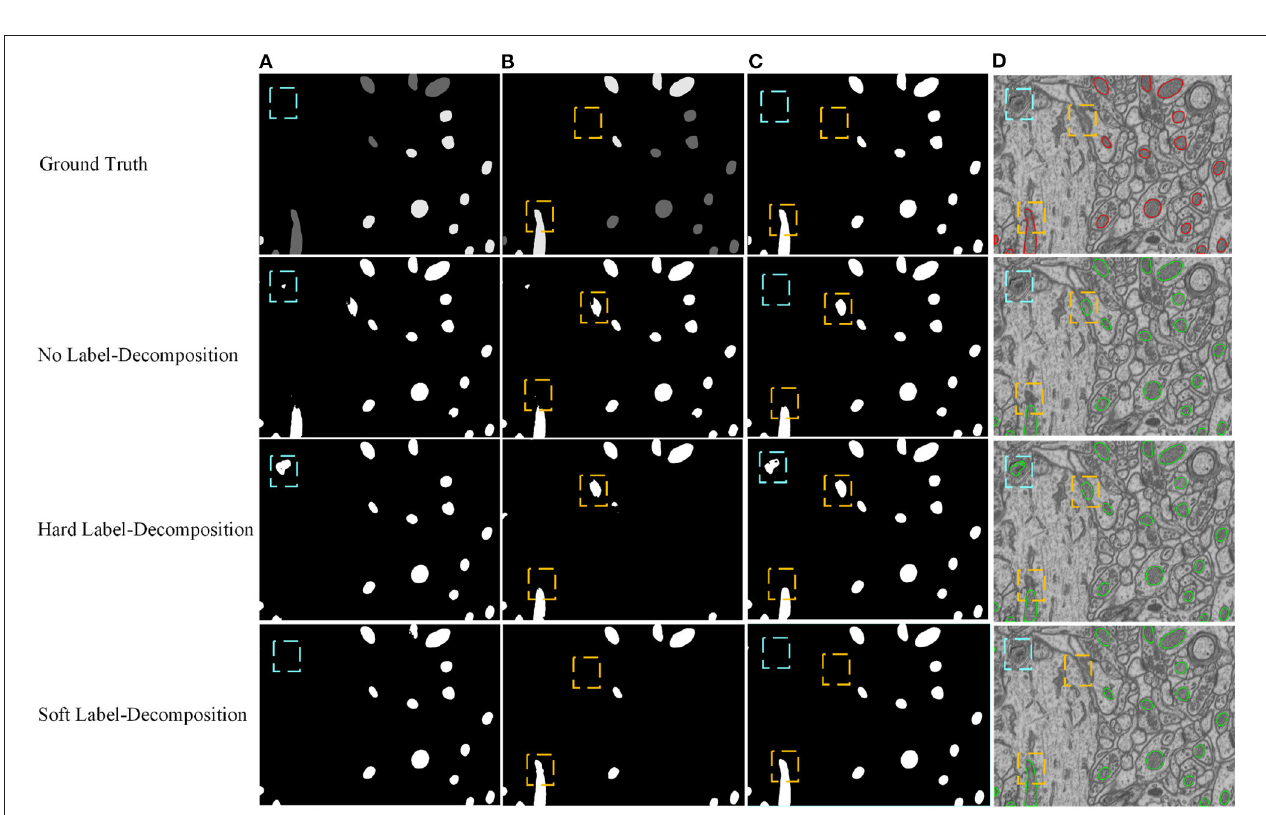
FIGURE 7 | Visual comparison of our model with its ablated versions on the EPFL dataset. (A) Ground truth, (B) 2D U-Net, (C) HED-Net w/o label-decompn, (D) HED-Net.